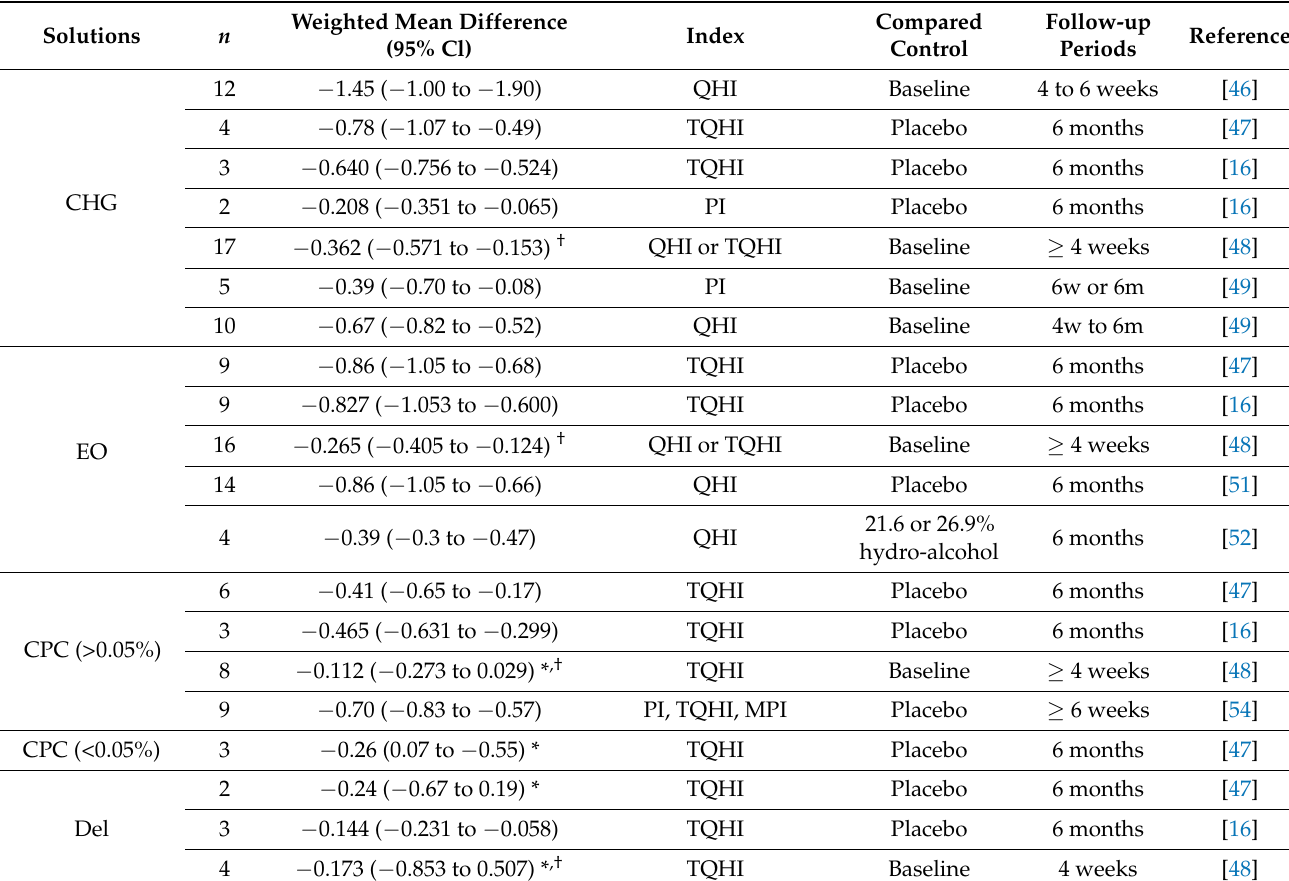
Table 2. Summary of the reductions in plaque